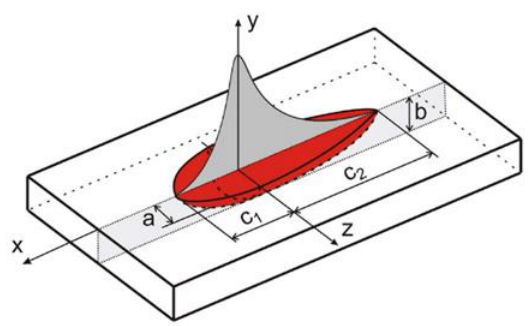
Figure 10. Scheme of Goldak’s model (Equation